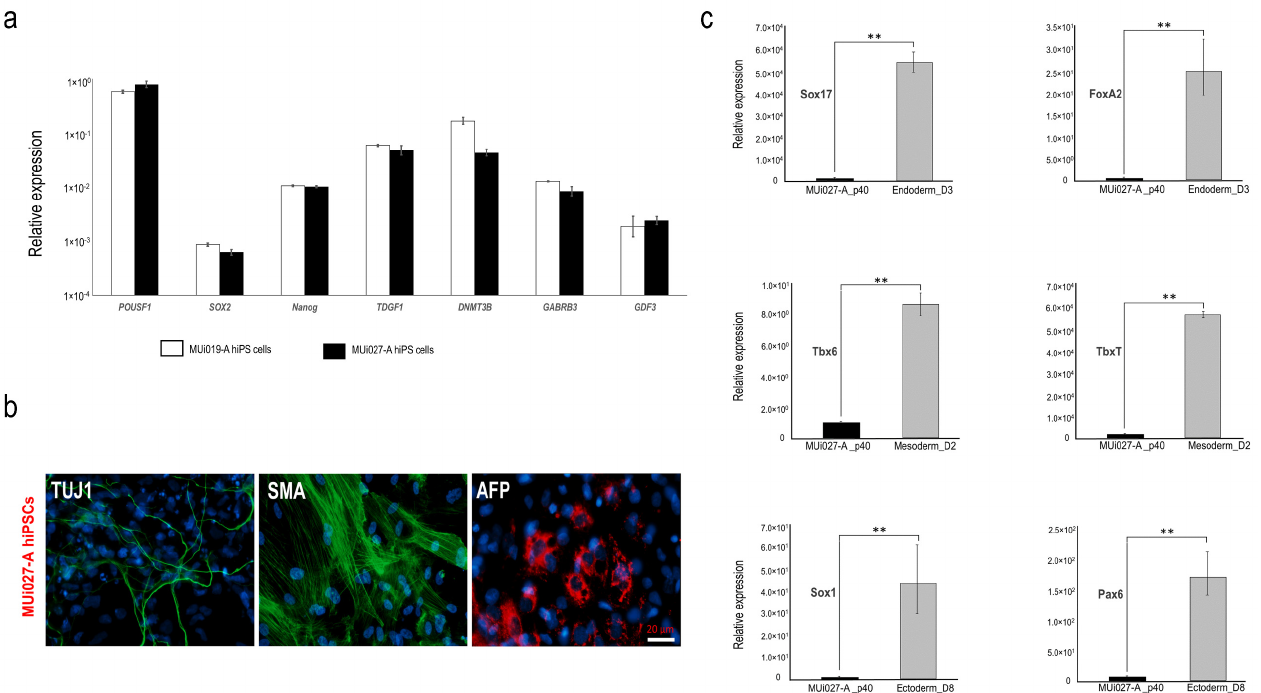
Figure 3. Pluripotency properties of MUi027-A iPSCs. ( a ) Real-time PCR of pluripotency genes in MUi027-A iPSCs. Expression levels of pluripotency genes are compared to those in previously published human iPSC line (MUi019-A). ( b ) Immunostaining of MUi027-A hiPSCs with TUJ1, SMA, and AFP. Expression levels are normalized to GAPDH. ( c ) Differentiation of MUi027-A hiPSCs into the three germ layers. Graphs depict the relative expression level of germ layer differentiation using real-time PCR for Sox17 and FoxA2 (Endoderm), Tbx6 and TbxT (Mesoderm), and Sox1 and Pax6 (Ectoderm). Expression levels are compared to those in undifferentiated iPSCs. Relative expression values are normalized to GAPDH. Data represents mean ± SEM ( n = 3), ** p < 0.01.